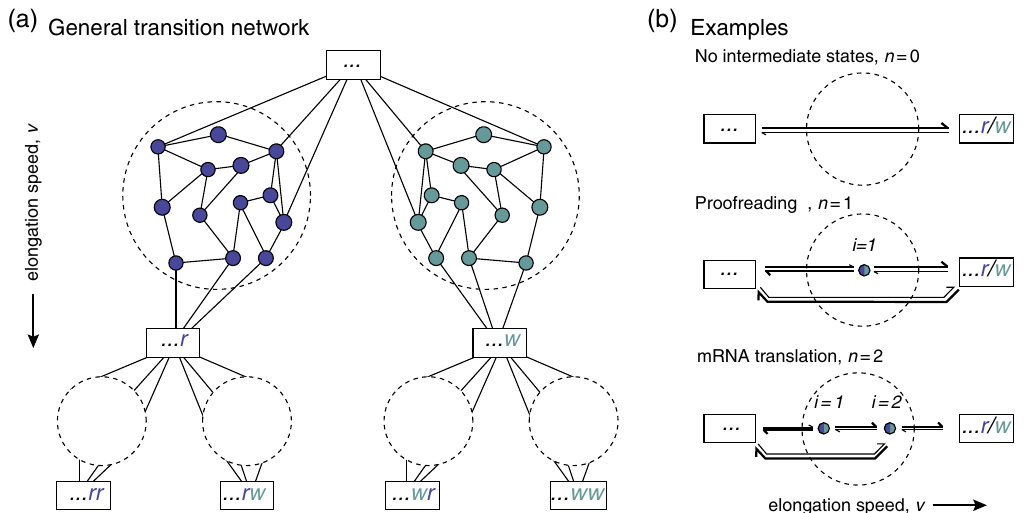
FIG. 2. Transition network of template-assisted polymerization and examples. (a) State space of the template-assisted polymerization model. Monomer incorporation occurs via a network of intermediate states represented inside the dashed circles. The two colors distinguish networks leading to incorporation of right and wrong monomers. The structure is repeated in a tree-shaped structure as the polymer grows by addition of more and more monomers. (b) Examples of networks of intermediate states. First example: template- assisted polymerization without intermediate states (see, e.g., Refs. [8,11 – 13,15]). Second example: kinetic proofreading, where after an intermediate state a backwards-driven pathway removes errors to improve the overall accuracy of the copy [4,13]. Third example: messenger RNA translation, where the three copying steps represent initial binding, GTP hydrolysis, and final accommodation; a proofreading reaction is also present